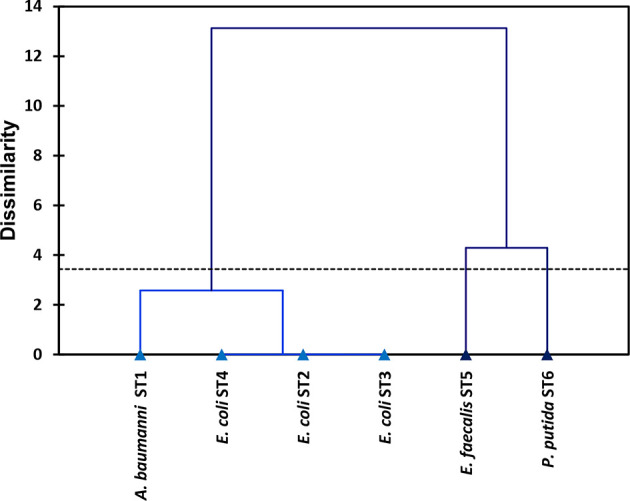
Hierarchical clustering analysis aligning the isolated sewage wastewater bacterial strains (n=6) on the basis of their antibiotic resistance and heavy metal tolerance profiles.